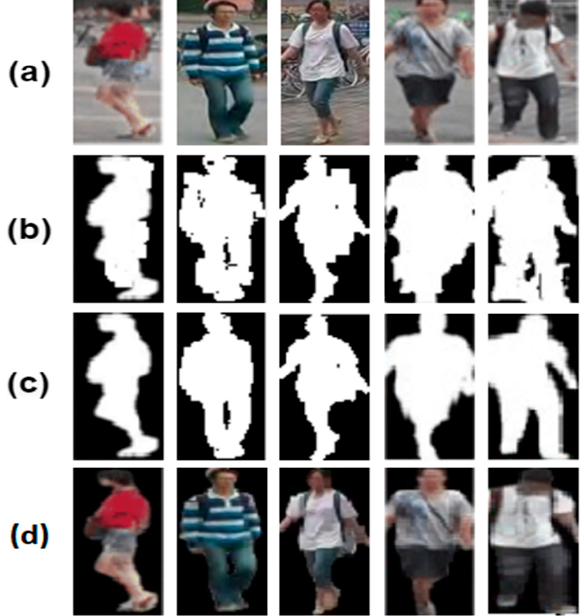
Figure 6. Some examples of applying the proposed person’s body segmentation procedure: ( a ) orig- inal images, ( b ) body mask generated from the Mask R-CNN, ( c ) body mask generated from the enhanced Mask R-CNN using the GrabCut algorithm, and ( d ) the final detected person’s body.